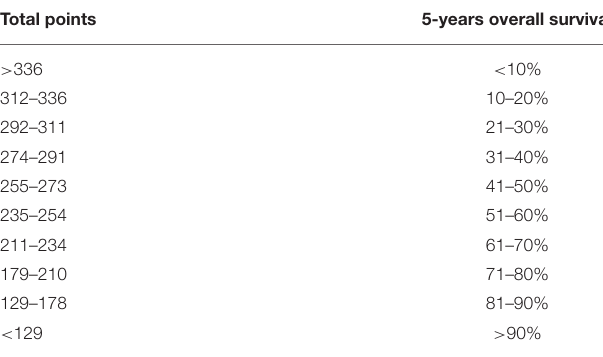
TABLE 4 | Relationship between total points and 5-years overall survival in colon